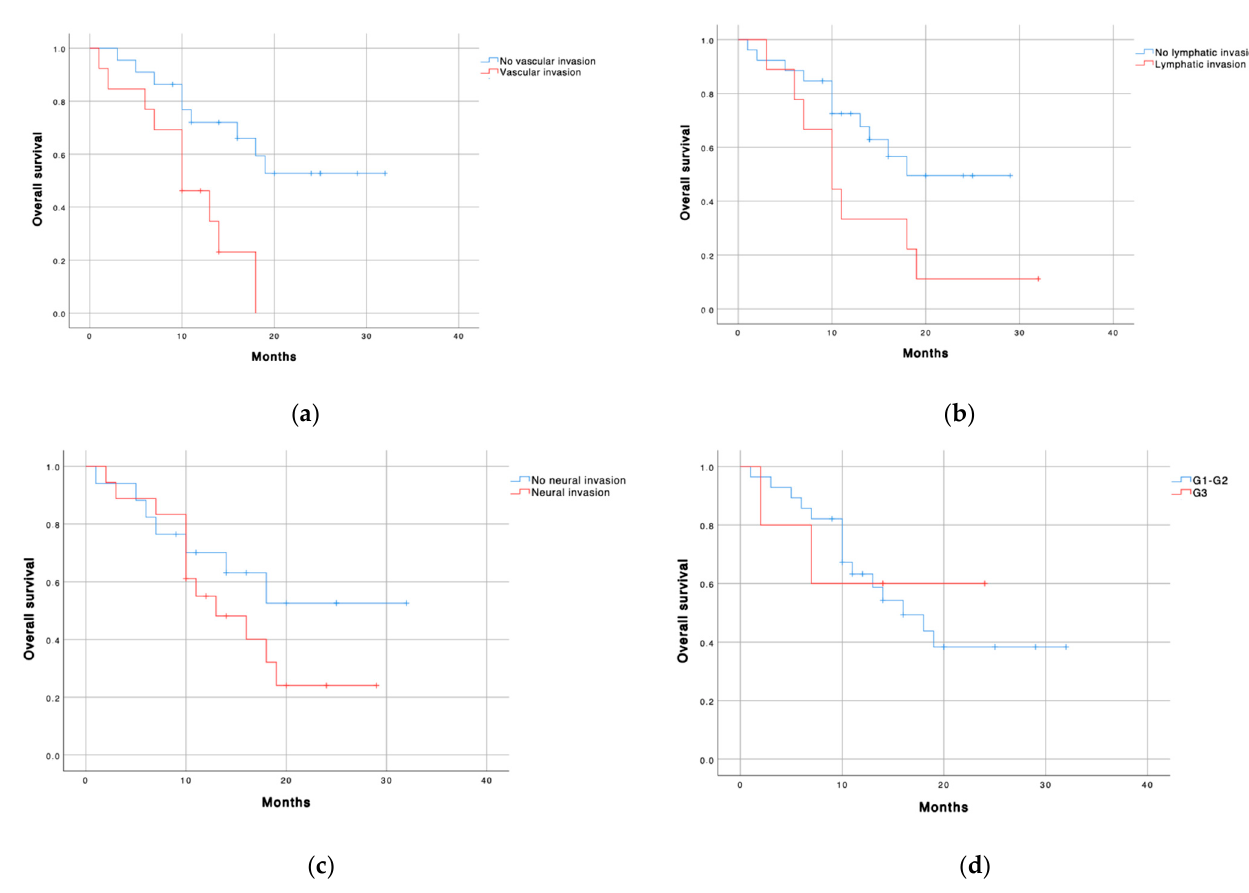
Figure 3. Overall survival according to ( a ) vascular invasion, HR = 3.568 (1.346–9.457); p = 0.011; ( b ) lymphatic invasion, HR = 2.418 (0.969–6.031); p = 0.058; ( c ) neural invasion, HR = 1.698 (0.666–4.328); p = 0.268; and ( d ) tumor grade differentiation, HR = 0.841 (0.196–3.771); p = 0.841. Blue line: no invasion or low grade (G1–2); red line: invasion or high grade (G3).